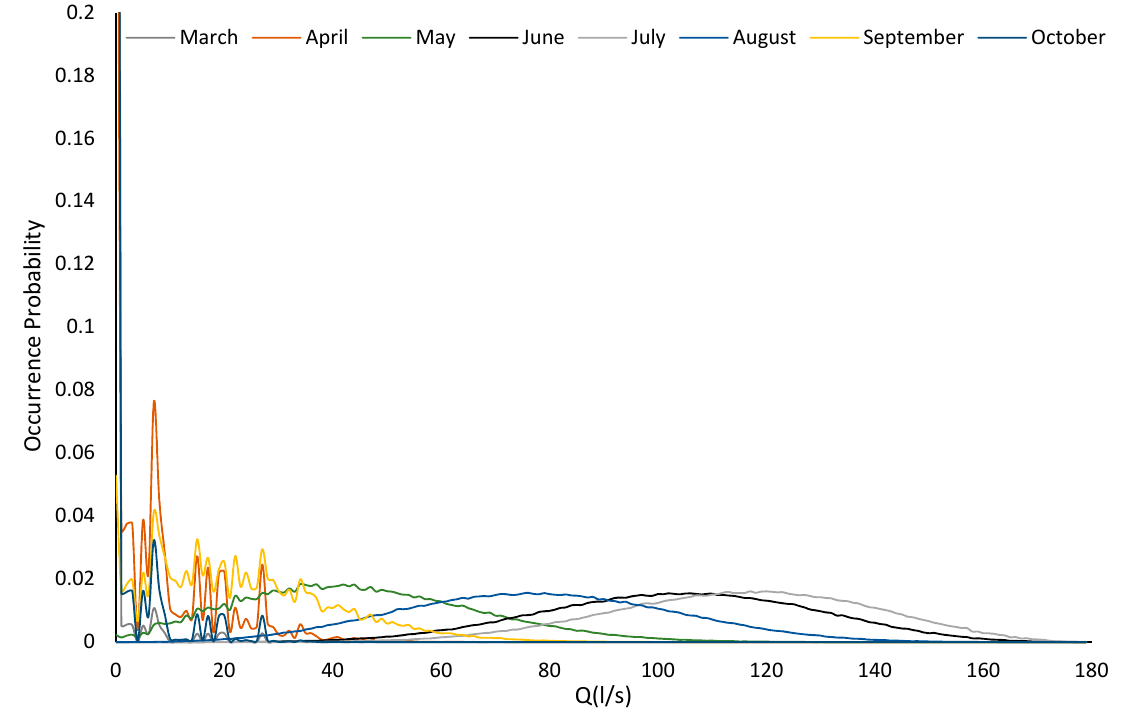
Figure 6. Mass function, p ( q ) , for the possible flow values in March, April, May, June, July, September and October for EPP 3. 020406080100120140160180200 s l / Q (